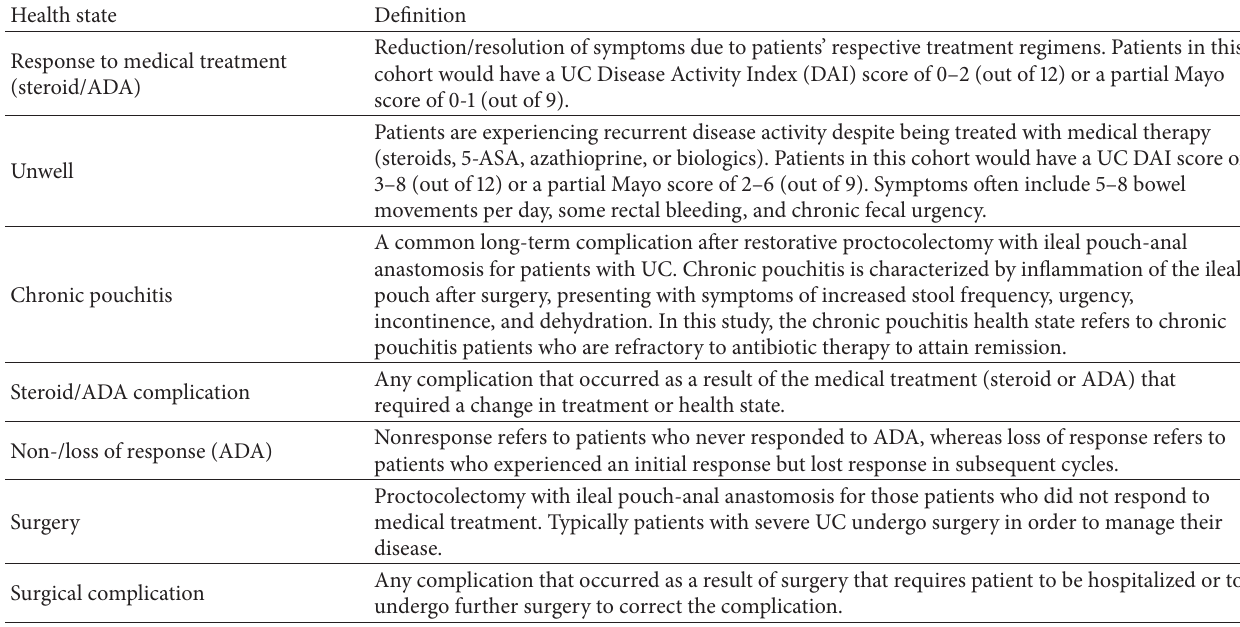
Table 2: Health state